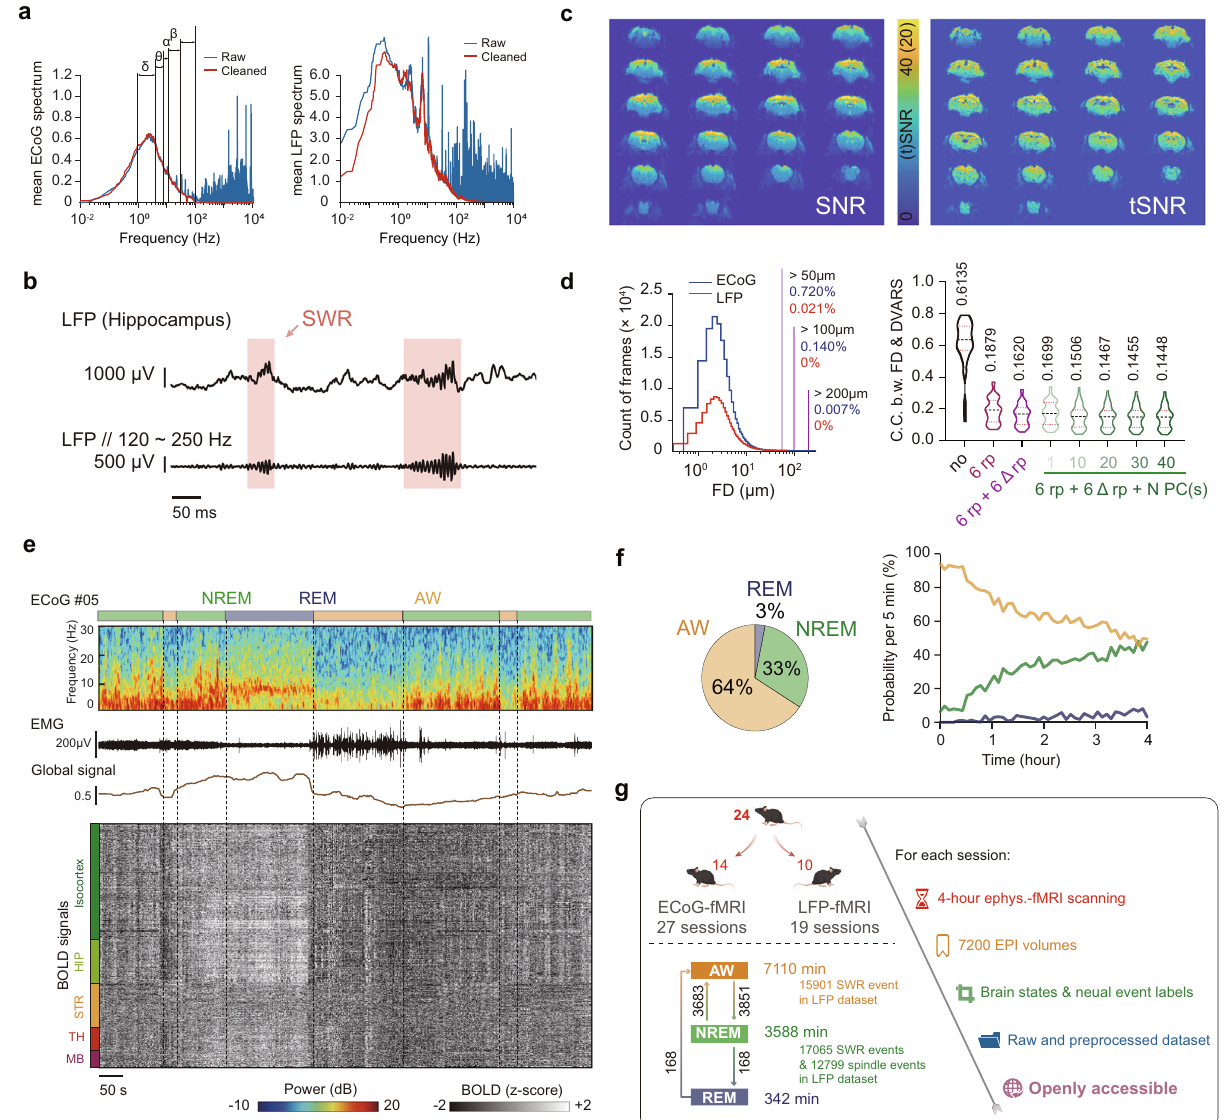
Fig.2|OverviewofmousesleepfMRIdataset.a Meanpowerspectrumofrawand denoised ECoG signals for ECoG-fMRI sessions and LFP signals for LFP-fMRI ses- sions. b RepresentativedenoisedLFPandEMGsignalsduringfMRIscanning.Upper panel, broadband (0.5~512Hz) LFP signal; Lower panel, band-pass fi ltered (120~250Hz) LFP signal. Red shadow indicated sharp wave ripple (SWR) events. c Representativeexampleof(temporal)signal-to-noise,i.e.,(t)SNR,ofourrawfMRI signal. d Small headmotion level ofECoG/LFP-fMRI sessions during fMRI scanning (left panel) and minimal head motion effects on BOLD signals after the “ 6 rp+6 Δ rp+40PCs ” regression(rightpanel).Notably,thein-planespatialresolutionofEPI images was 200 μ m. The number above each violin plot represented the mean Pearson ’ scorrelationcoef fi cients(C.C.)betweenframe-wisedisplacement(FD)and